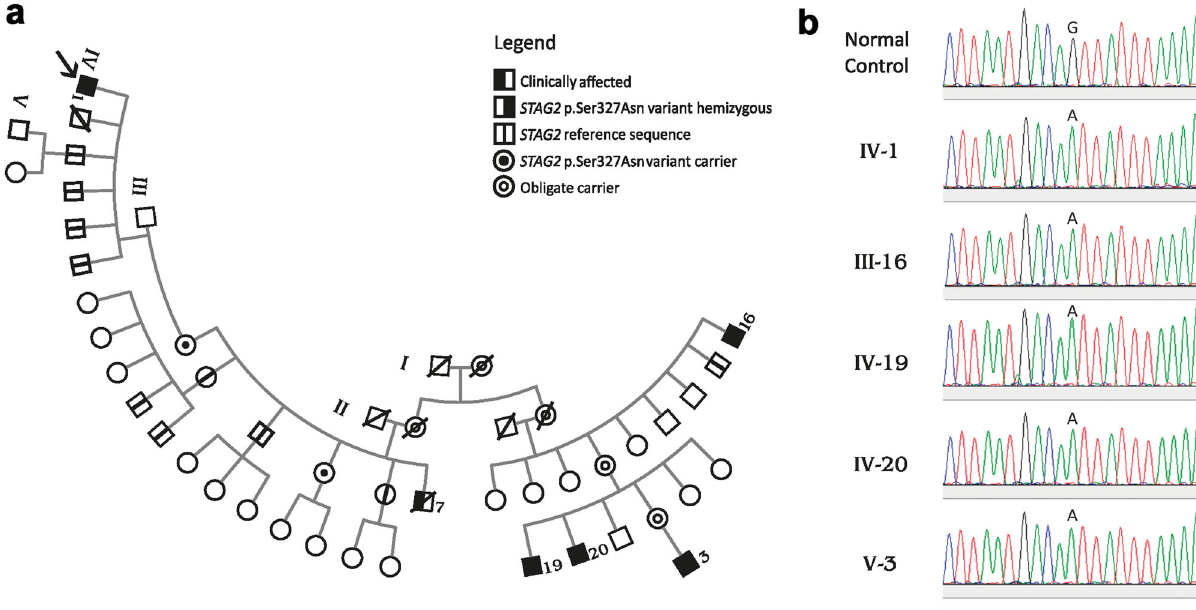
Fig. 1 Pedigree. a Pedigree shows typical X-linked recessive inheritance of the c.980 G > A (p.Ser327Asn) in the STAG2 gene (NM_001042749.1) on the X chromosome. The variant was studied in the proband ( arrow ) and in male and female relatives by allele-speci fi c PCR and con fi rmed in the proband and all affected male relatives by Sanger sequencing. b For Sanger sequencing we used the BigDye Terminator v3.1 Cycle Sequencing Kit (Applied Biosystems ® ) and the Applied Biosystems (ABI) 3130 Genetic Analyzer. Sequencing data were analyzed using the software Sequencher version 4.1.4 (Gene Code